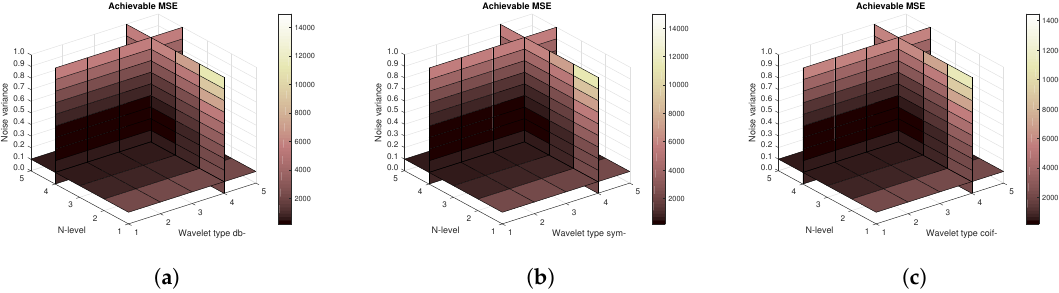
Figure 20. MSE in the presence of Salt and Pepper noise only for the CT scan from Figure 4 with use of three mother wavelet families—from left Daubechies ( a ), Symlet ( b ) and Coiflet ( c